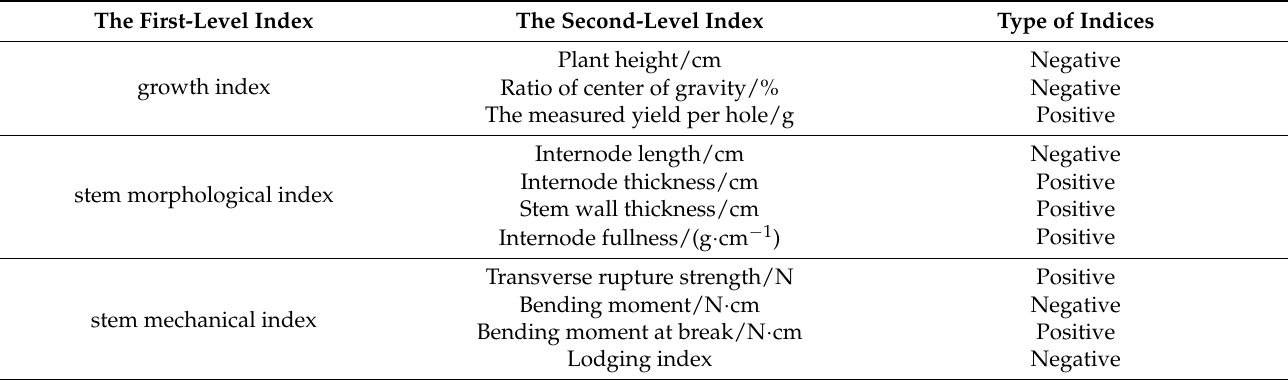
Table 8. Evaluation indices of the ENTROPY TOPSIS model.